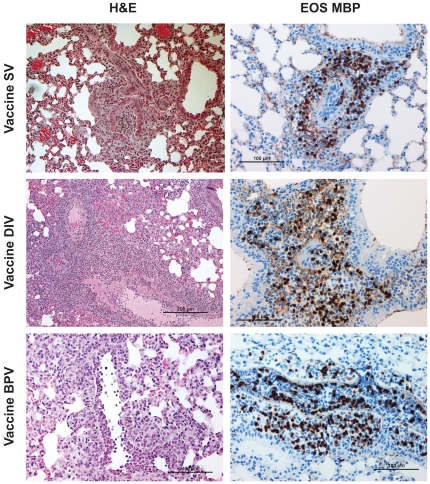
Photographs of Lung Tissue.Representative photomicrographs of lung tissue two days after challenge of Balb/c mice with SARS-CoV that had previously been given a SARS-CoV vaccine. Lung sections were separately stained with hematoxylin and eosin (H&E) and an immunohistochemical protocol using an eosinophil-specific staining procedure with a monoclonal antibody to a major basic protein of eosinophils. DAB chromogen provided the brown eosinophil identity stain. The procedure and antibody were kindly provided by the Lee Laboratory, Mayo Clinic, Arizona. The H&E stain column is on the left and eosinophil-specific major basic protein (EOS MBP) stain column is on the right. Vaccines: double inactivated whole virus (DIV), β propiolactone inactivated whole virus vaccine (BPV). As shown in the images, eosinophils are prominent (brown DAB staining) in all sections examined. Exposure to SARS-CoV is associated with prominent inflammatory infiltrates characterized by a predominant eosinophilic component.